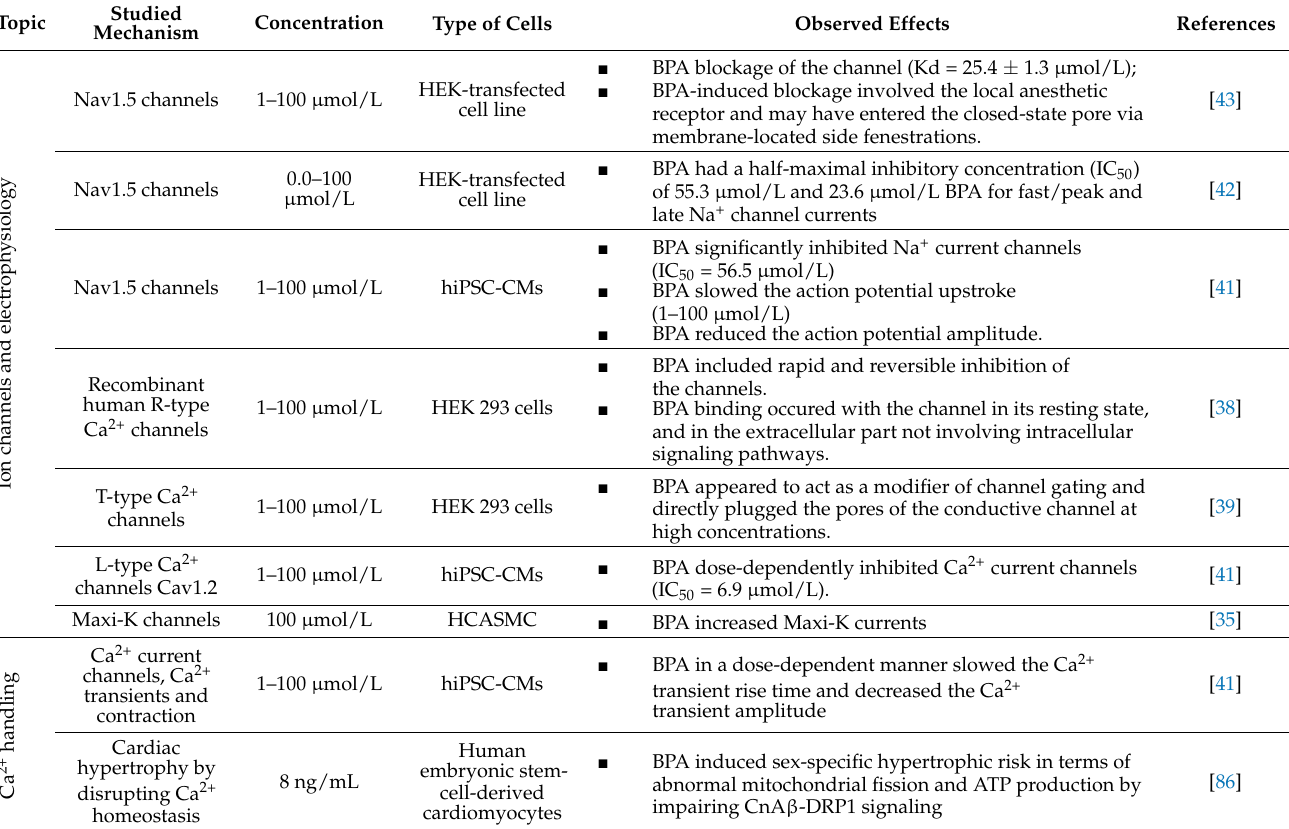
Table 4. Summaries of the disruptive effects of BPA in in vitro studies using human cell lines 1 . Observed